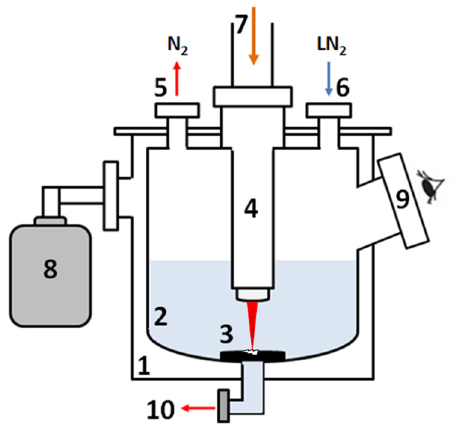
Figure 1. Diagram of the experimental argument: homemade irradiation cryostat to synthesize N-MoS 2 QDs in LN 2 . 1—chamber of vacuum, 2—reservoir of LN 2 , 3—mount of MoS 2 target, 4— beam guidance section, 5—outlet of ventilation (N 2 evaporator), 6—inlet of LN 2 , 7—window of laser irradiation, 8—pump of rotary, 9—optical window for monitoring and 10—product yield location (outlet)